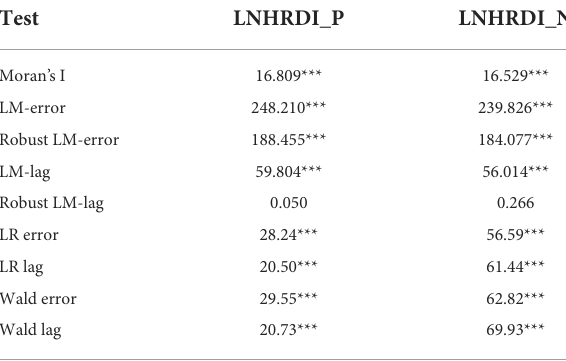
TABLE 4 Constraint statistics of the spatial econometric